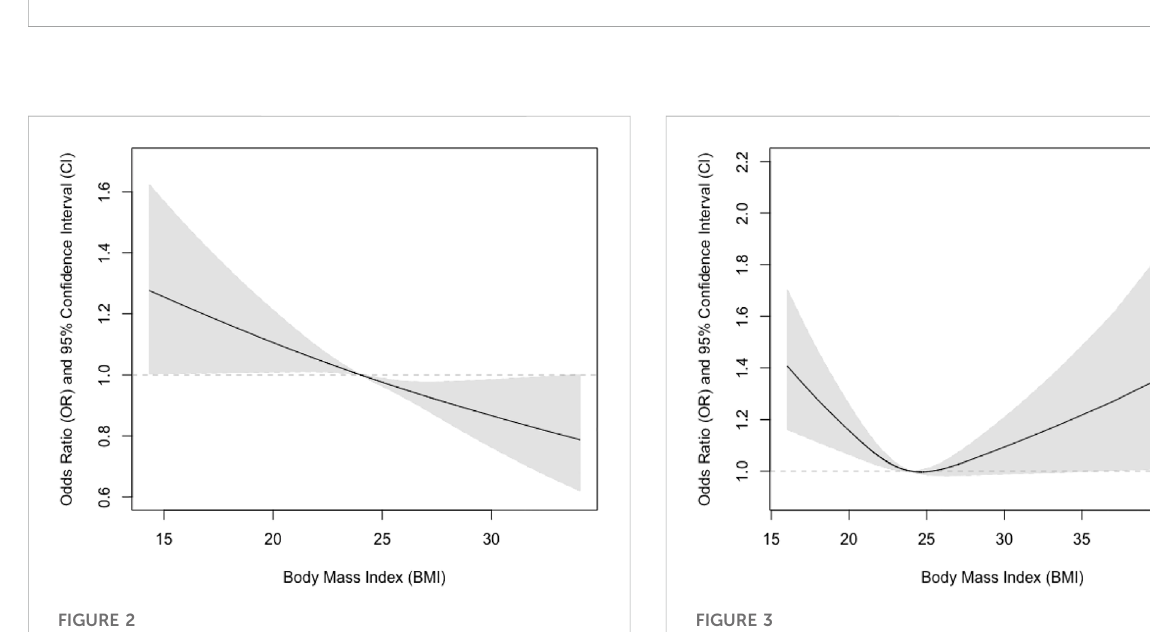
FIGURE 1 Association between body mass index and pulmonary air fl ow limitation in men and women.